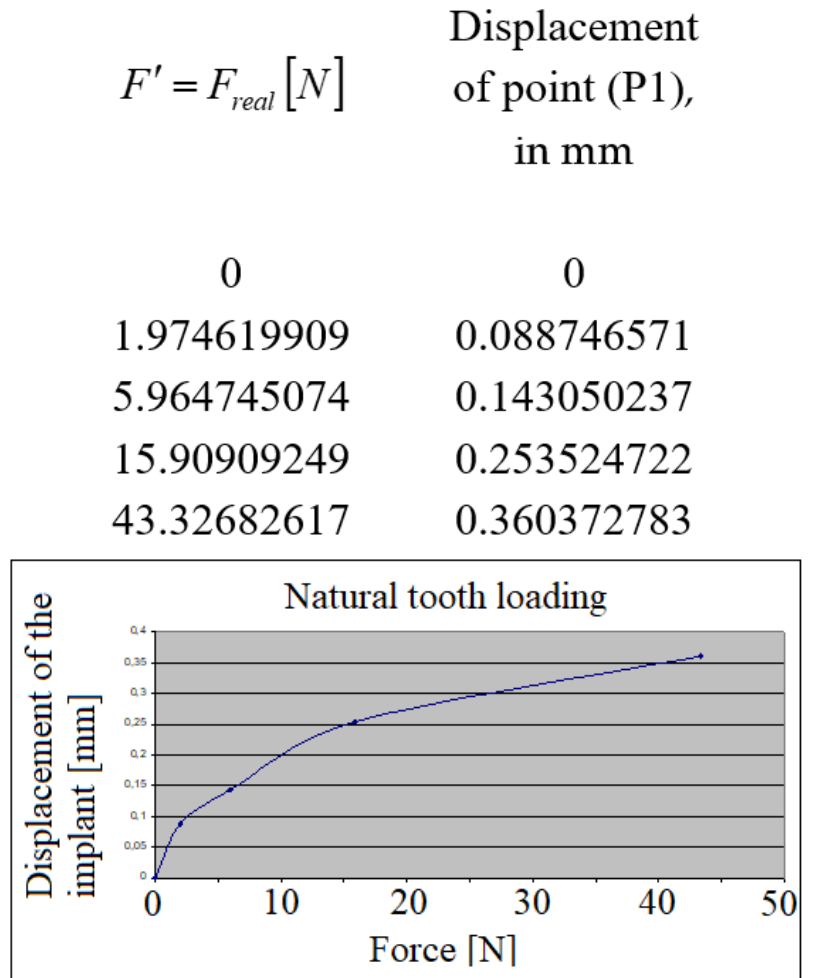
Figure 8. The natural tooth’s displacement during its loading. The curvilinear aspect of the response of the periodontal ligament system of the maxillary natural tooth can be observed. Meanwhile, the unloaded dental implant displacements resulted in a similar, curvilinear aspect (Figure 9).